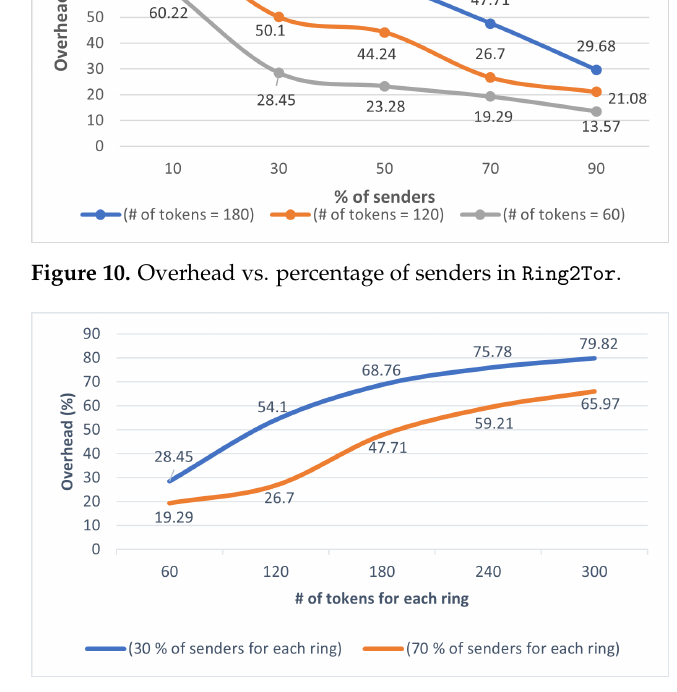
Figure 11. Overhead vs. Number of tokens in Ring2Tor .